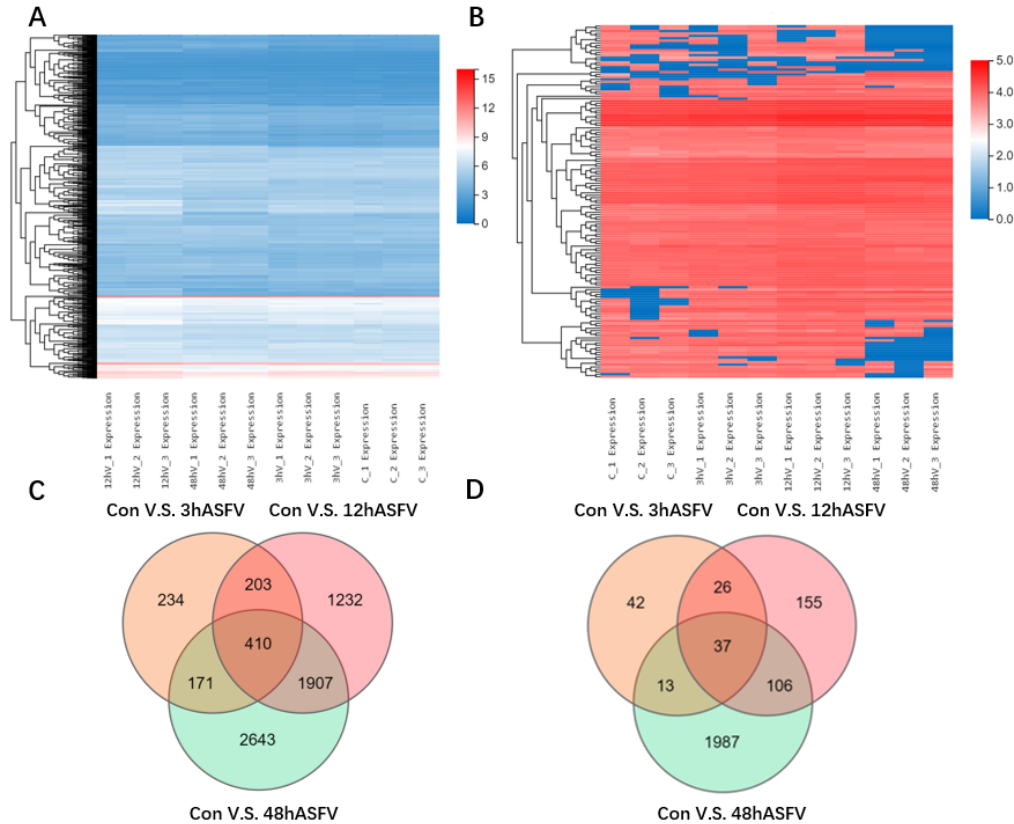
Figure 2. Conjoint analysis of transcriptomics and proteomics. Primary PAMs were infected with GZ201801 at an MOI of 1, and harvested samples 3 h, 12 h, and 48 h post-infection were sequenced for transcriptomics ( A ) and proteomics ( B ). Three sets of experiments were repeated at each time point, and the omics results were analyzed by cluster heat map. The differential genes ( C ) and differential proteins ( D ) at the three time points of ASFV infection were illustrated using Venn diagrams.